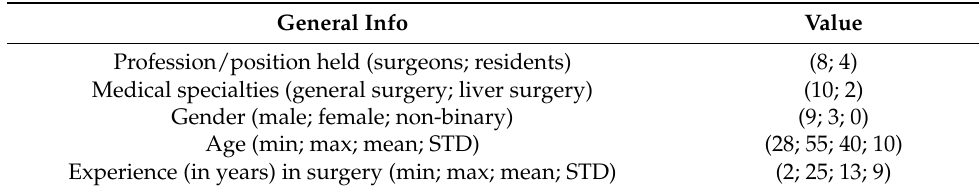
Table 2. Demographics of participants in the user study.